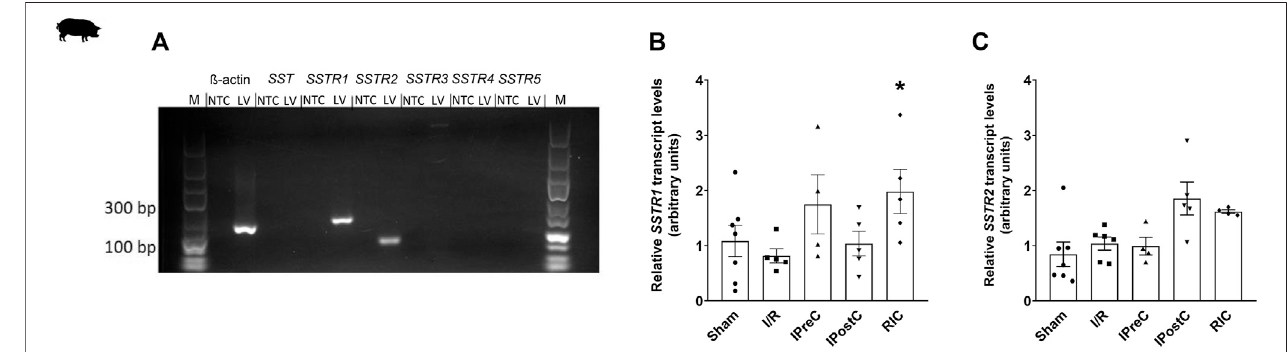
FIGURE4| Expressionofsomatostatin and its receptors inporcine left ventricle samples (A) .The outerlanescontainaDNA ladder (M). Notemplate control(NTC) sampleswithoutcDNAdidnotgiveanyampli fi cationproductswiththeusedprimers,indicatingthatcontaminationwasnotpresent.Productsizes: β -actin:133bp;SST: 117 bp; SSTR1: 139 bp; SSTR2: 82 bp; SSTR3: 110 bp; SSTR4: 112 bp; SSTR5: 98 bp. Relative gene expression ratios of SSTR1 (B) and SSTR2 (C) in left ventricle samples. Transcript levels were normalized to ß-actin. Data are presented as mean ± SEM. The Kruskal-Wallis test and Dunn ’ s post hoc test, * p < 0.05 vs. I/R